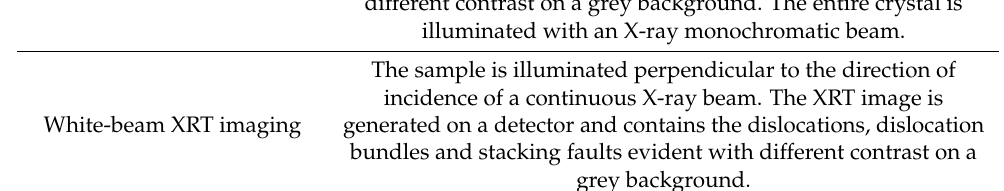
Table 1. The summary of the three XRT techniques used for dislocation mapping. Rocking curve is measured for each detector pixel at a Bragg angle corresponding to a crystal plane. For each detector pixel, the FWHM is calculated from the rocking curve, and an FWHM Rocking curve mapping map is created. The higher the value of FWHM, the higher the concentration of dislocations at the location. The entire crystal is illuminated with an X-ray monochromatic beam. The sample XRT image is taken at a particular Bragg angle corresponding to a crystal plane. The image contains the dislocations, dislocation bundles and stacking faults evident with different contrast on a grey background. The entire crystal is illuminated with an X-ray monochromatic beam.